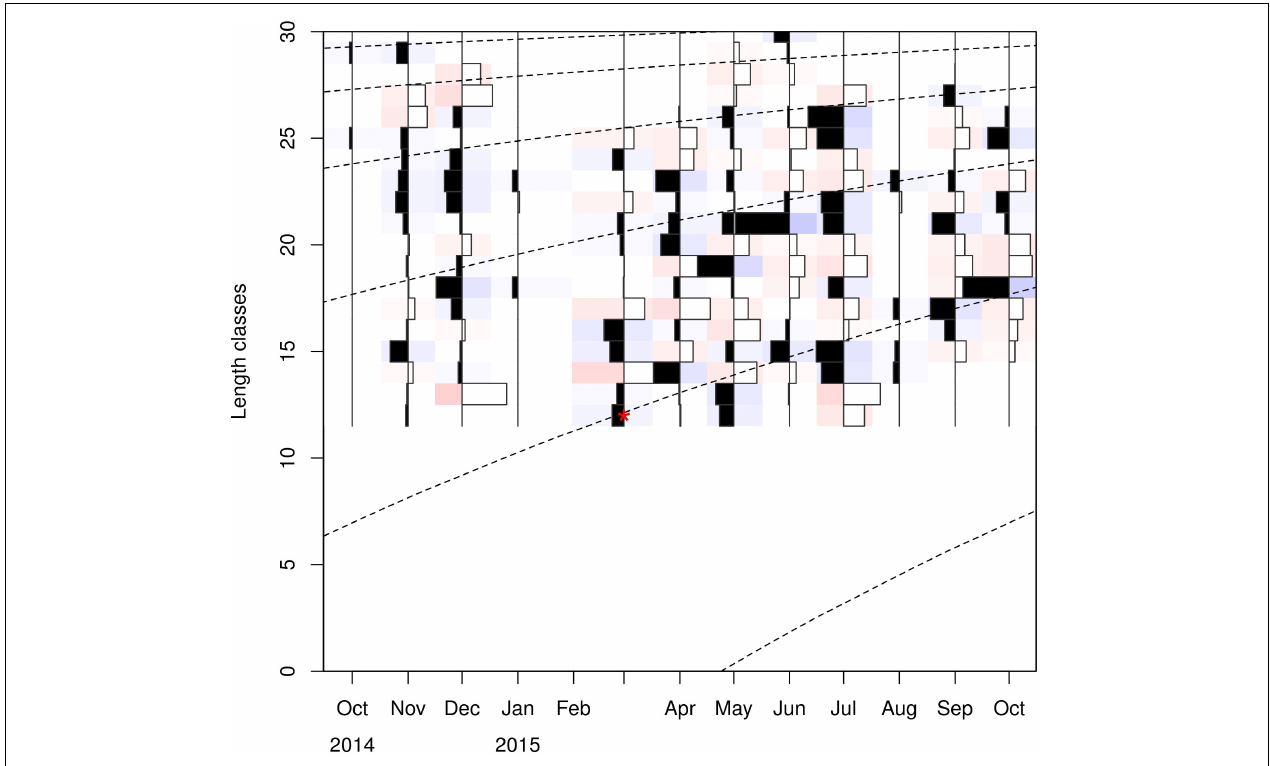
FIGURE 5 | Age cohorts (dashed lines) estimated by the VBGF model. Red asterisk indicates the size at which the youngest individuals are captured. Length classes (CL) are in mm.